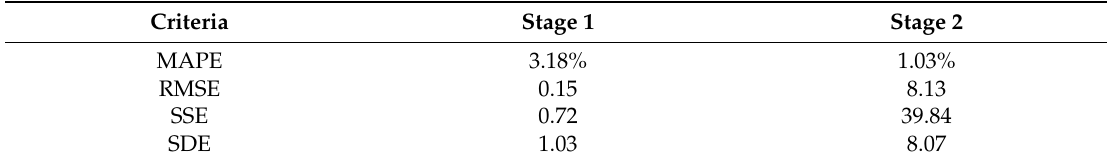
Table 3. Accuracy Analysis of the Proposed Method—Winter Day.